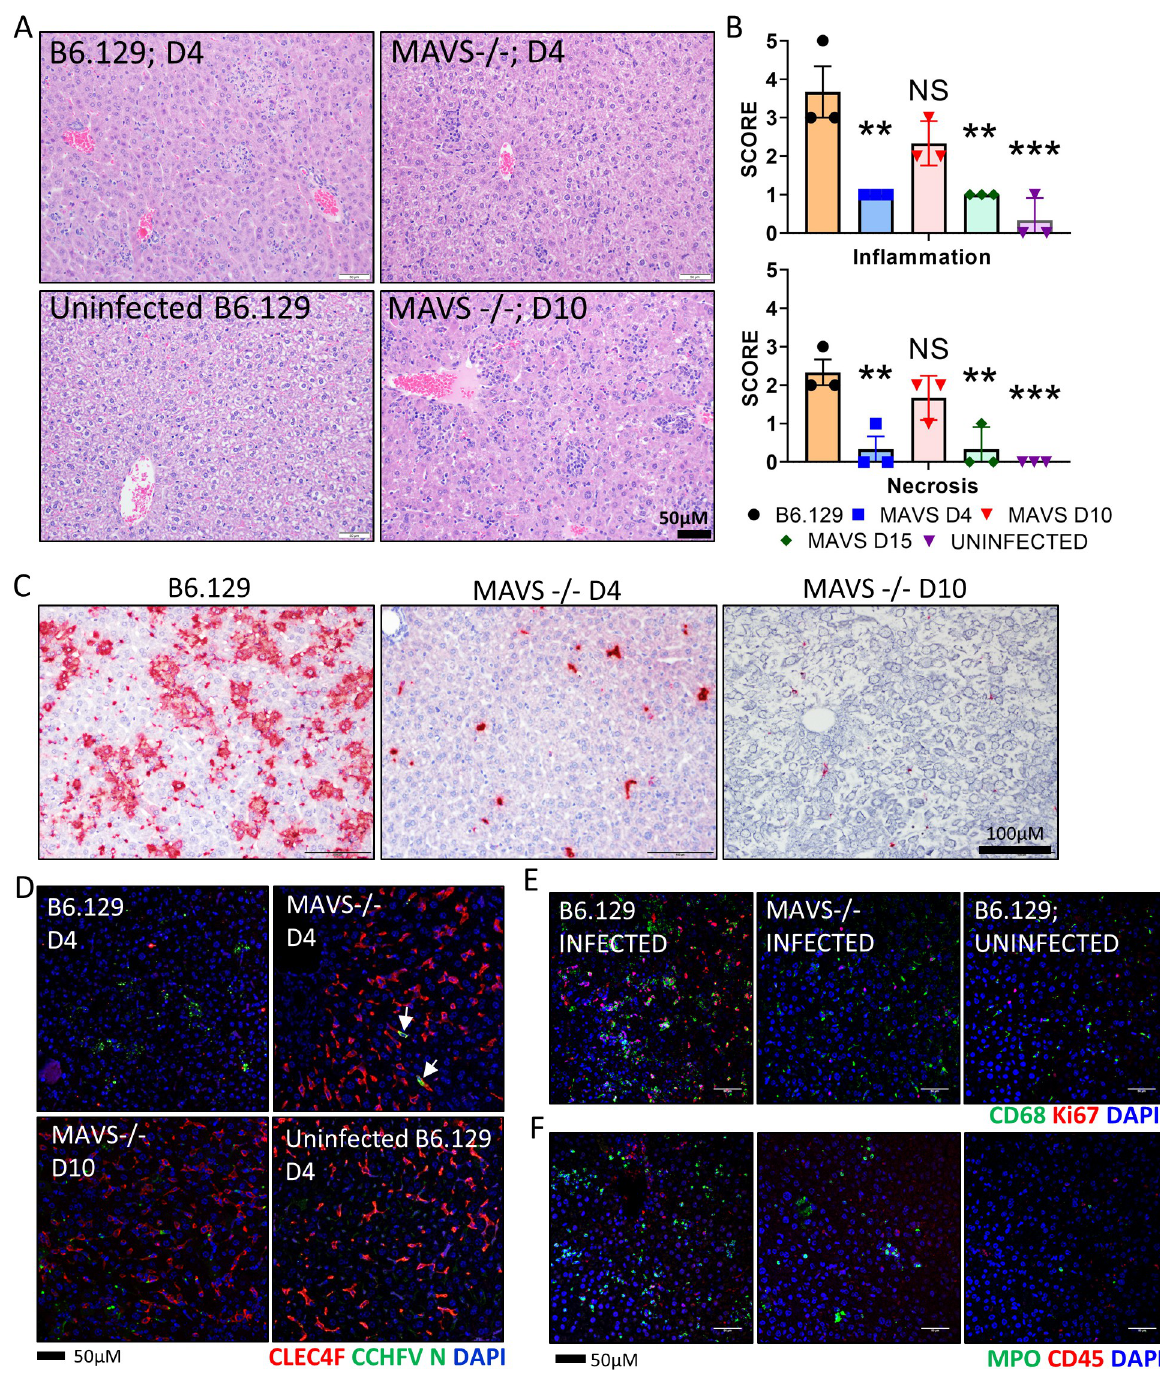
Fig 2. Hepatic injury is reduced in CCHFV infected MAVS KO mice. A. Representative H&E staining of livers from WT (Day 4) and MAVS KO mice infected with CCHFV in the presence of IFN-I blockade harvested on Day 4 and 10 (n = 3/group/time point). mAb-5A3 treated Day 4 B6.129 mice show increased liver pathology compared to MAVS KO mice or uninfected mice. Inflammation and necrosis were increased in the liver on day 10 in the MAVS KO mice, compared to the day 4 in the MAVS KO mice, but pathology was still less severe than in the WT (B6.129) mice. B. Pathology scores for WT (Day 4) or MAVS KO mice (Day 4, 10 and 15) were plotted for the indicated lesions (n = 3 per group). Statistical significance of infection in MAVS KO mice compared to infected controls was determined by one-way ANOVA; �� p < 0.05, ��� p < 0.001 or NS; not significant. C Representative ISH staining of livers. ISH stained tissue was counterstained with hematoxylin. D. Liver sections from infected (WT [B6.129] or MAVS KO) or uninfected WT (B6.129) mice were stained with anti-CLEC4F (red) and anti-CCHFV N protein antibodies (green). Cell nuclei were stained with DAPI. E and F . IFA demonstrates increased number of CD68 + macrophages (E, green) and